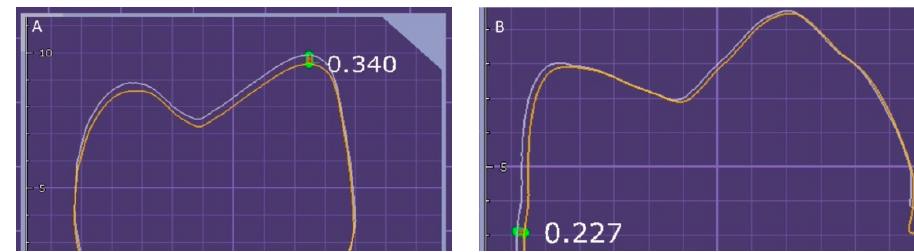
Figure 3. The measuring point of occlusal surface ( A ) and B-L surface ( B ).